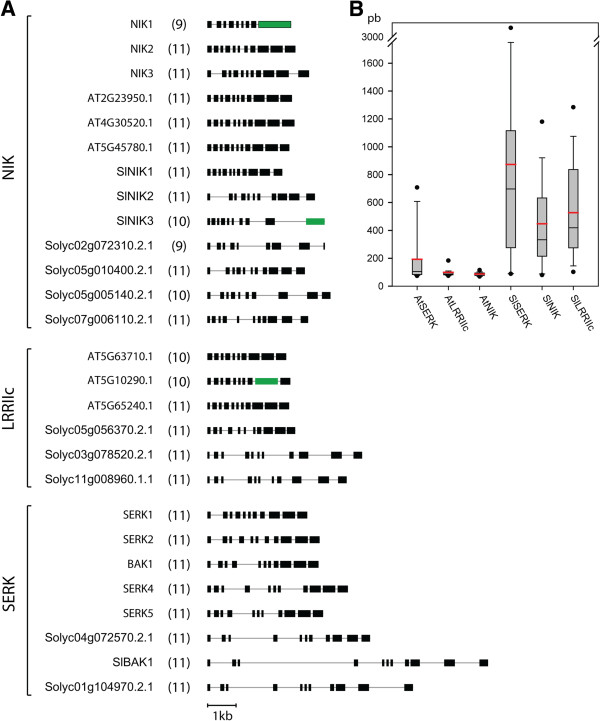
Genomic structure analysis of members of the LRRII subfamily of tomato and Arabidopsis. (A) Exons are shown as dark boxes and introns as grey lines. Green boxes represent fused exons. The number between parentheses represents the number of exons in each gene. Almost all genes contain 11 exons. (B) Boxplot illustrating the distribution of intron length among LRRII clades of Arabidopsis and tomato. The red line marks the average intron length. Note the large length of intronic regions in SERK genes compared with genes from other clades, and in tomato sequences compared with Arabidopsis sequences.